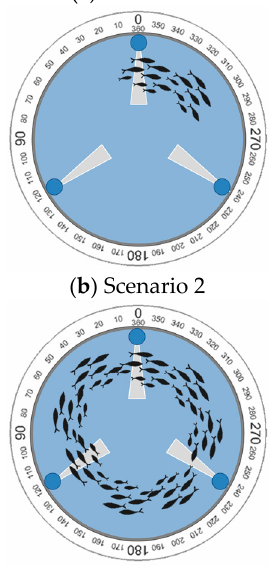
Figure 19. Fish shoal distribution in tested scenarios and LDR location. Sensors 2018 , 18 , x FOR PEER REVIEW